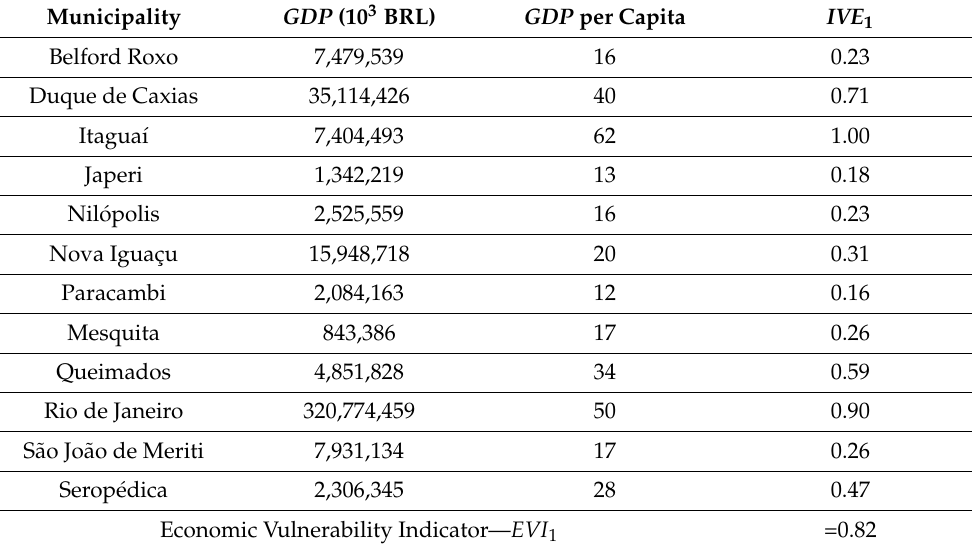
Table 18. Economic vulnerability indicator ( EVI 1 ) application.